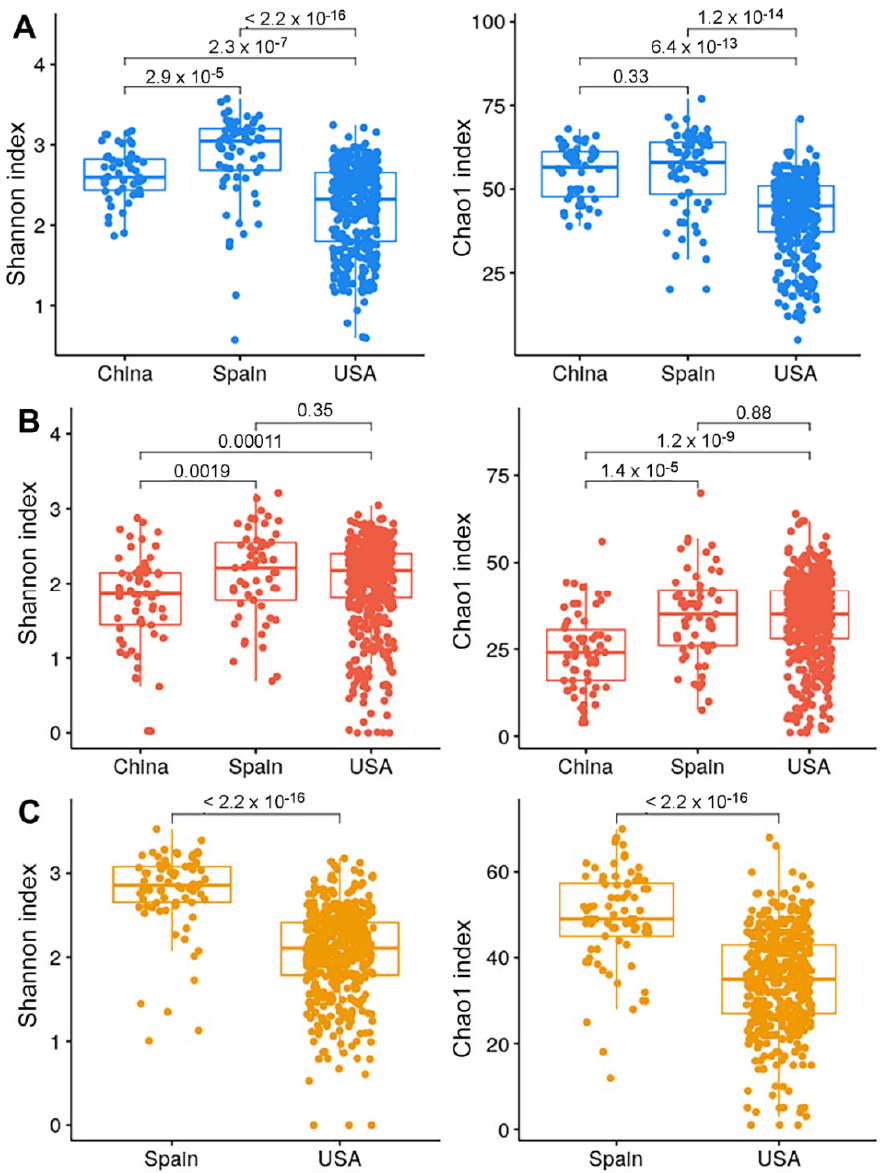
Figure 4. Alpha-diversity based on health status across countries. Shannon and Chao1 indices in HC ( A ), CD ( B ), and UC ( C ) (Mann-Whitney’s U test).